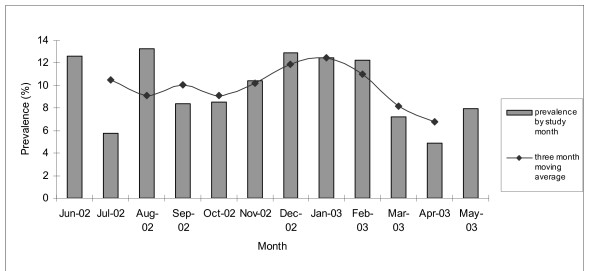
Monthly prevalence of acute gastrointestinal illness by study month with three month moving average, in the province of British Columbia, Canada.